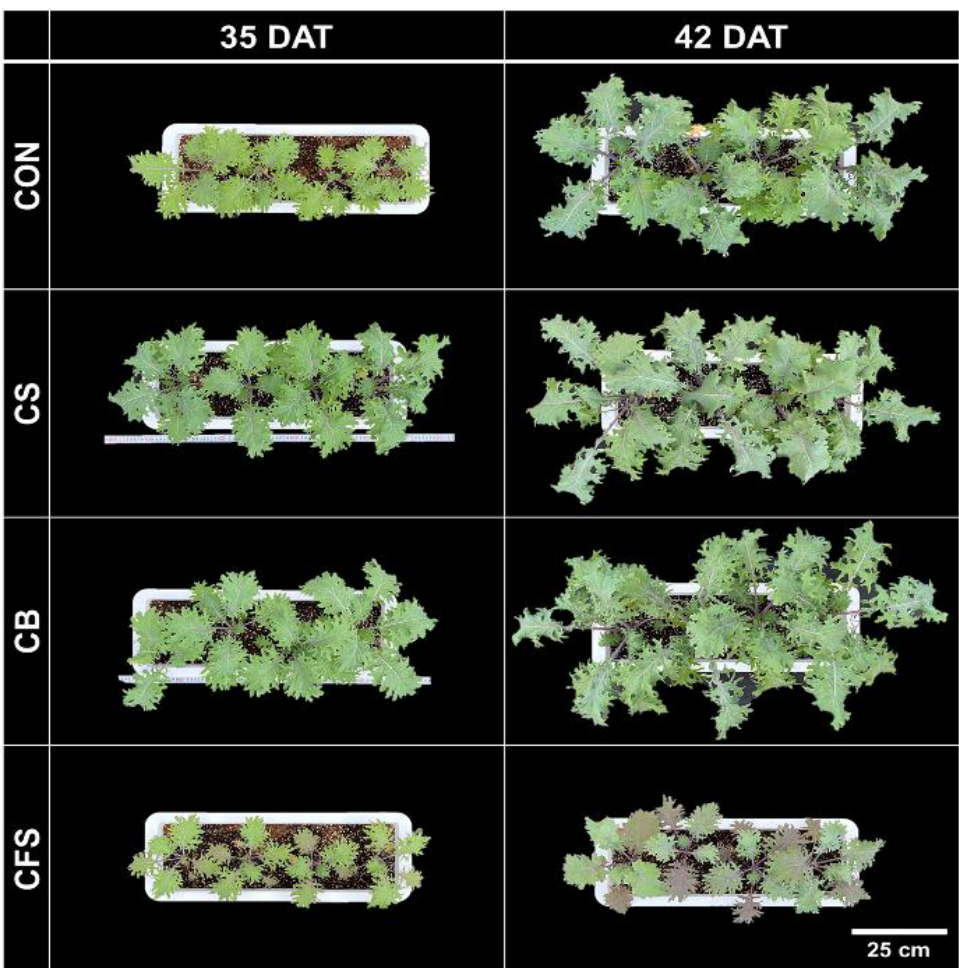
Figure 2. Morphological changes in “Red Russian” kale after 100 × Chlorella treatments. The scale bar indicates 25 cm. CON, distilled water; CS, Chlorella suspension; CB, Chlorella biomass; CFS, Chlorella − free supernatant.